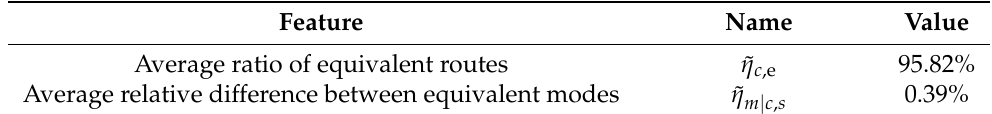
Table 4. Main results of the evaluation of steps 4 and 5 of PROMOTING. Table 4. Shown are the main results of the evaluation of steps 4 and 5 of PROMOTING.